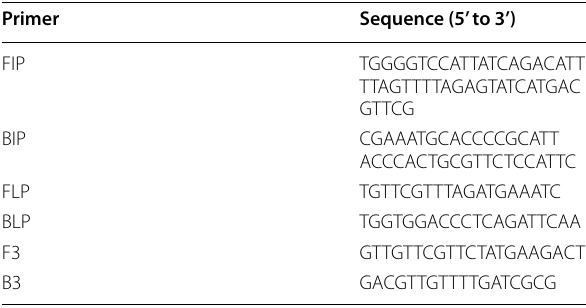
LAMP reaction indicated sky blue and negative reaction remained in violet